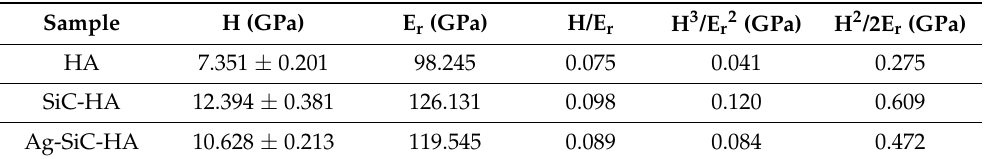
Table 5. The obtained averaged values of reduced elastic modulus E r and hardness H, along with various ratios of H and E r values (H/E r , H 3 /E r2 , H 2 /2E r ). Sample H